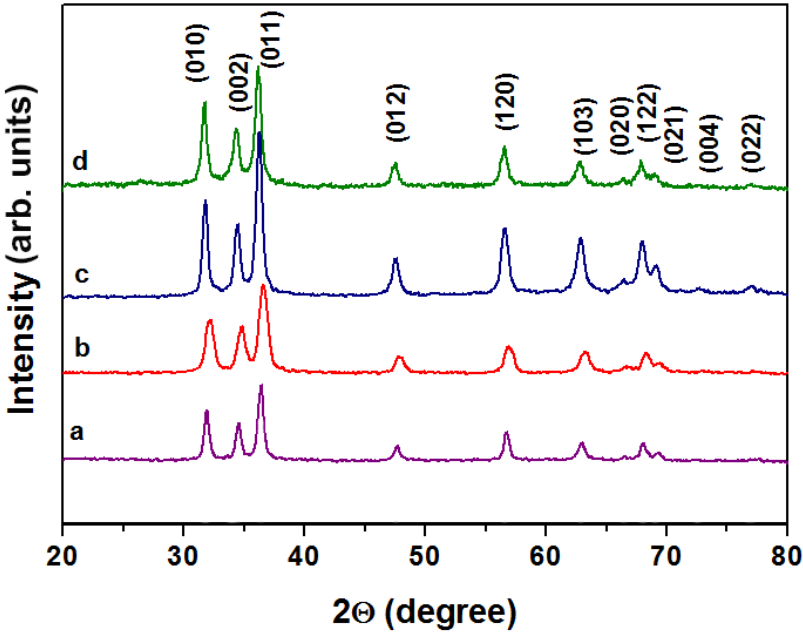
Figure 2. XRD patterns of ZnO-SnO 2 films under study: pure ZnO (curve a), Sn:Zn = 0.5:99.5 (curve b), Sn:Zn = 1:99 (curve c), Sn:Zn = 5:95 (curve d).